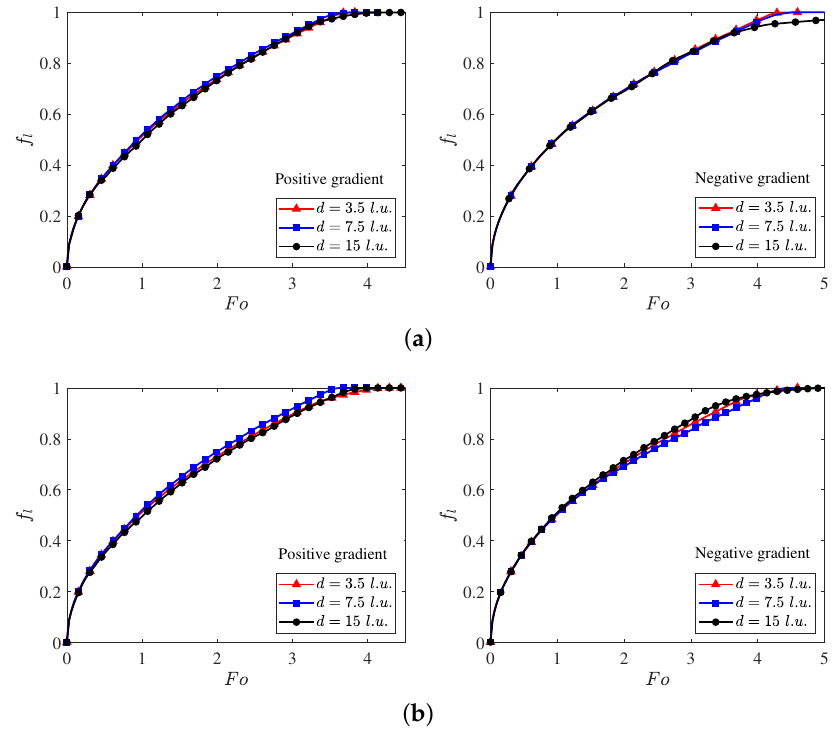
Figure 10. Comparisons of liquid fraction at different particle diameters for Ra = 10 4 , in which Ste = 0.1, and Pr = 0.2: ( a ) Case A; ( b ) Case